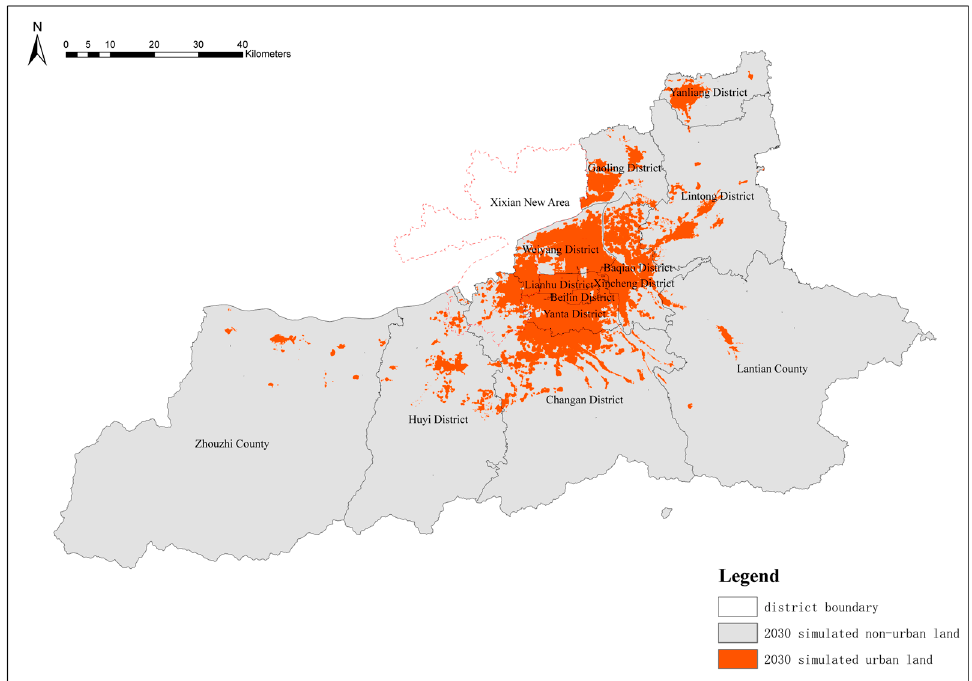
Figure 6. Urban growth simulation in 2030.